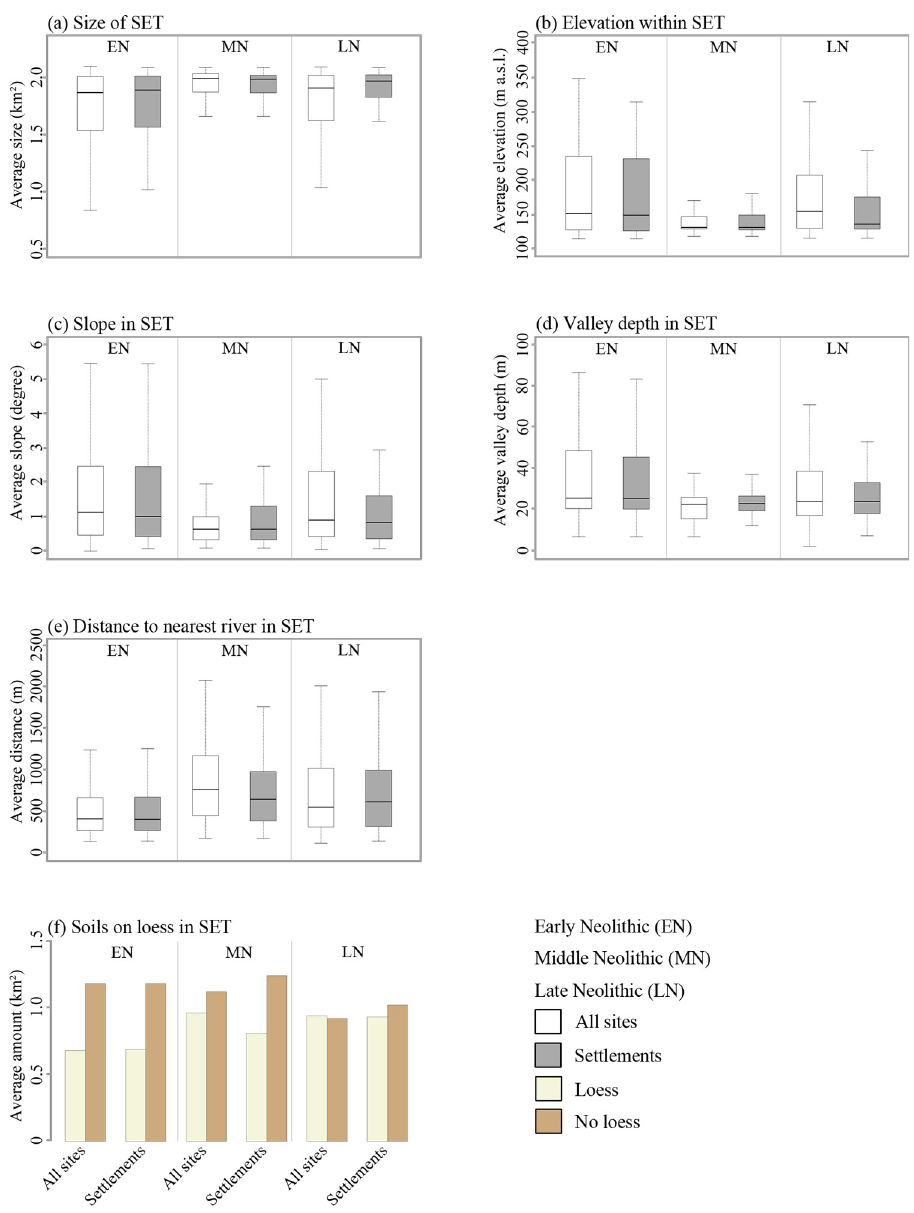
Fig 9. Analyses of site exploitation territories. (a) Size of modelled SET, (b) terrain elevation, (c) slope, (d) valley depth, (e) river distance and (f) soils on loess and. For more information on each terrain covariate see S1 Table. average for all sites for the respective periods. The opposite is true for the Middle Neolithic (Fig 9D). For all sites, an increased river distance of about 450 m can be observed with the transition from the Early Neolithic (about 520 m) to the Middle Neolithic (980 m). For the Late Neo- lithic, the average river distance decreased to about 820 m. The values for Early and Late Neo- lithic settlements did not differ from those observed for all sites from the respective periods. In contrast, the average river distance within SETs of Middle Neolithic settlements is approx. 100 m lower compared to all sites from that period (Fig 9E).